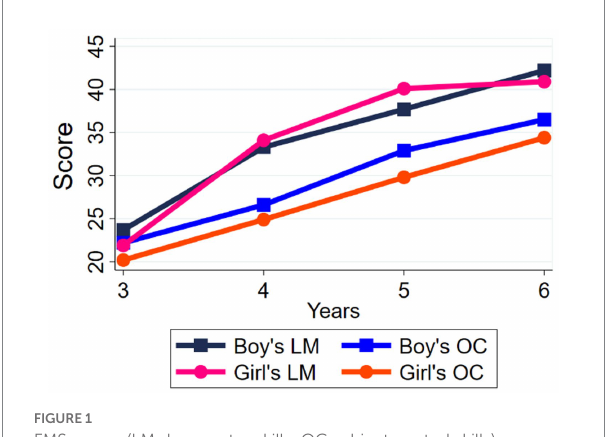
FIGURE 1 FMS scores (LM = locomotor skills; OC = object control